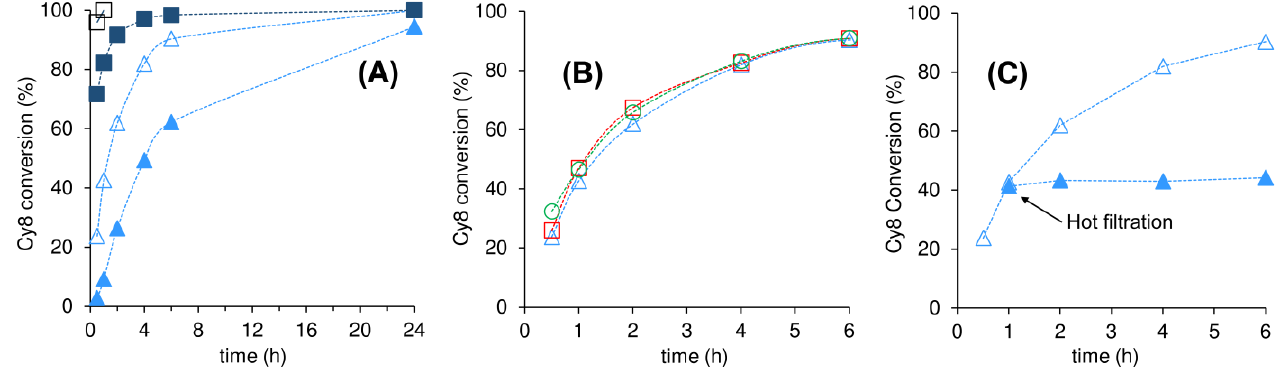
Figure 7. Cis -cyclooctene (Cy8) epoxidation with TBHP in TFT for the systems: ( A ) 1 /55 °C ( ■ ), 1 /70 °C ( □ ), 2 /55 °C ( ▲ ), and 2 /70 °C ( ∆ ); ( B ) 2 /70 °C (run 1 ( ∆ ), run 2 ( □ ), run 3 ( ○ )); ( C ) 2 /70 °C (normal run ( ∆ ) and leaching test ( ▲ )). Dashed lines are visual guides. Cy8O was the only product formed for all reactions (Cy8O selectivity = 100%).